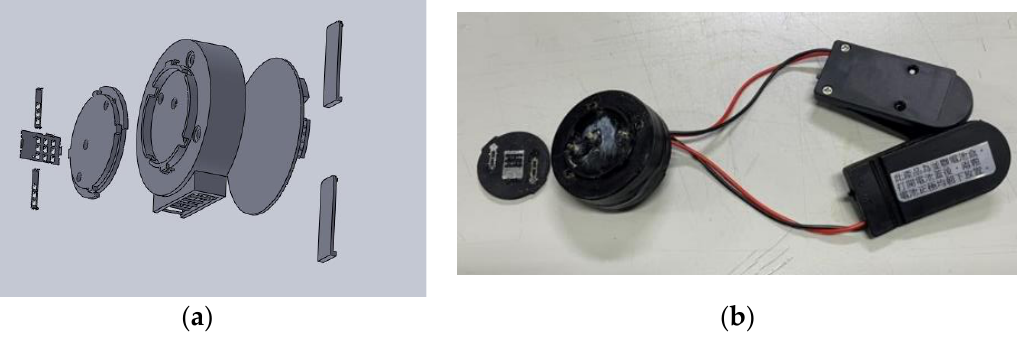
Figure 9. ( a ). The exploded view drawing of the housing system created using SOLIDWORKS: from left to right are the three-electrode microneedle arrays, upper cover, circuit board shell, lower cover, and battery holder. ( b ). The appearance of the assembled sensor.